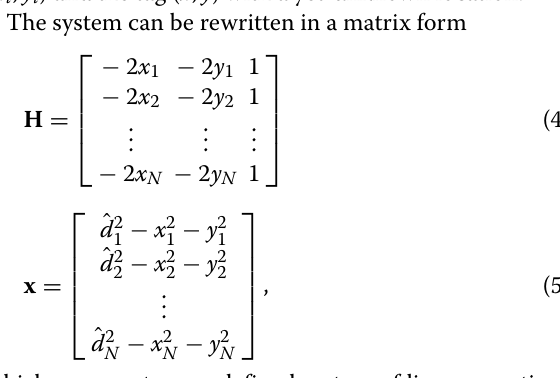
a more complex tracking algorithm based on extended Kalman filter is presented in Section